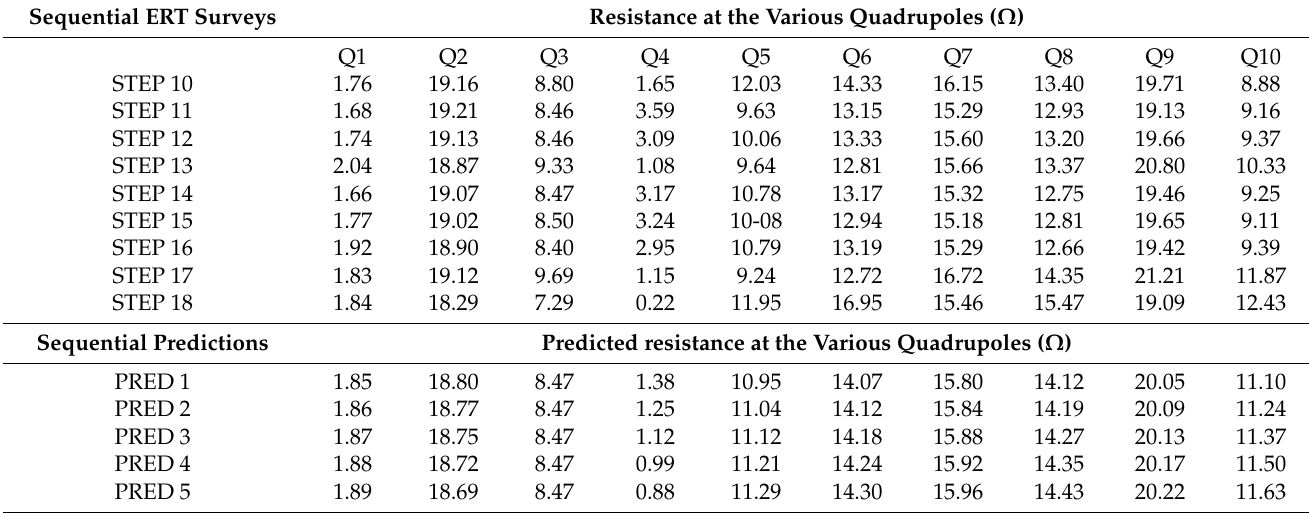
Table 2. Experimental measurements and corresponding predictions using Vector Autoregressive (VAR) statistical method.